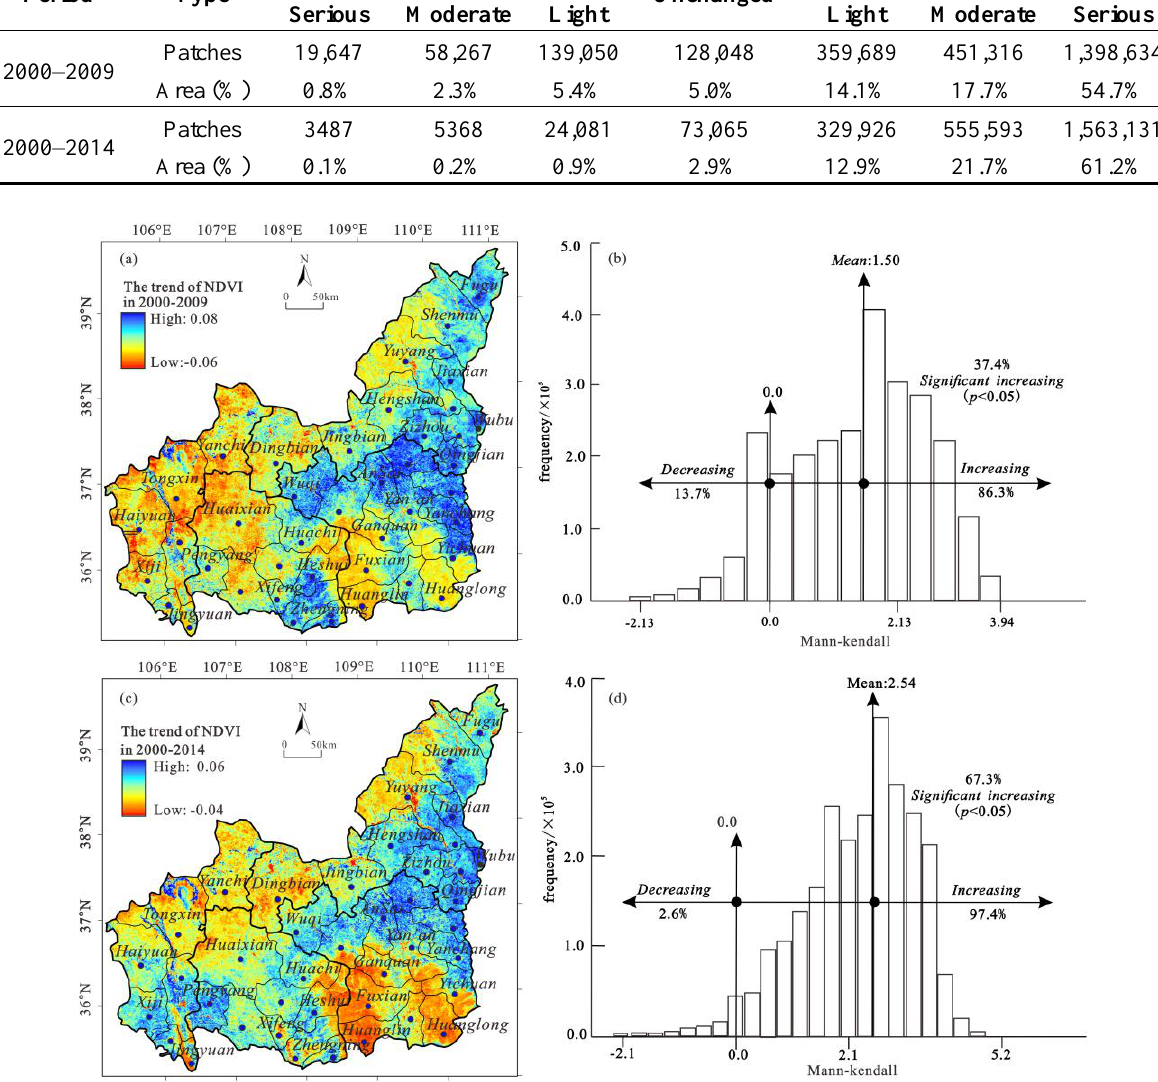
Table 3. NDVI changes in the Shaanxi-Gansu-Ningxia region during 2000–2009 and 2000–2014.